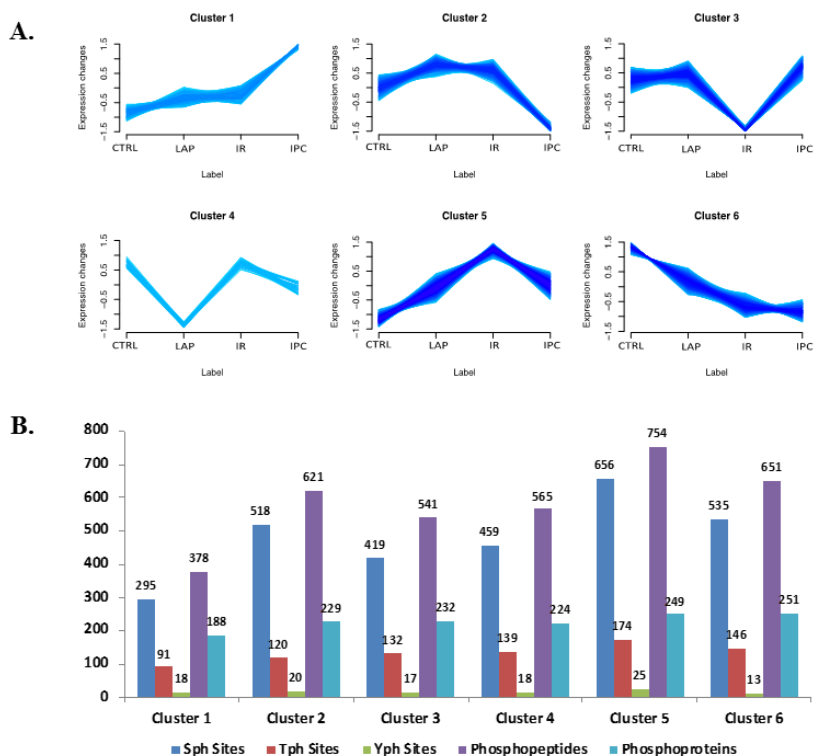
Figure 3. ( A ) Cluster-based relative abundance profiles of the identified proteins and phosphopeptides in Ctrl, Lap, iIR, and iIPC from rat neutrophil. ( B ) Phosphosites, phosphopeptides, and phosphoproteins distribution across the six